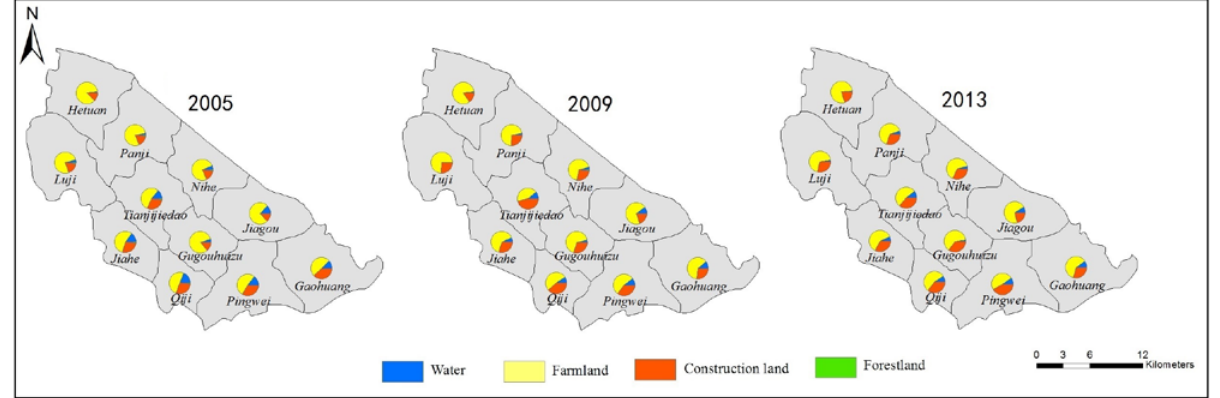
Figure 4. Spatial variation of landscape types in each town in Panji